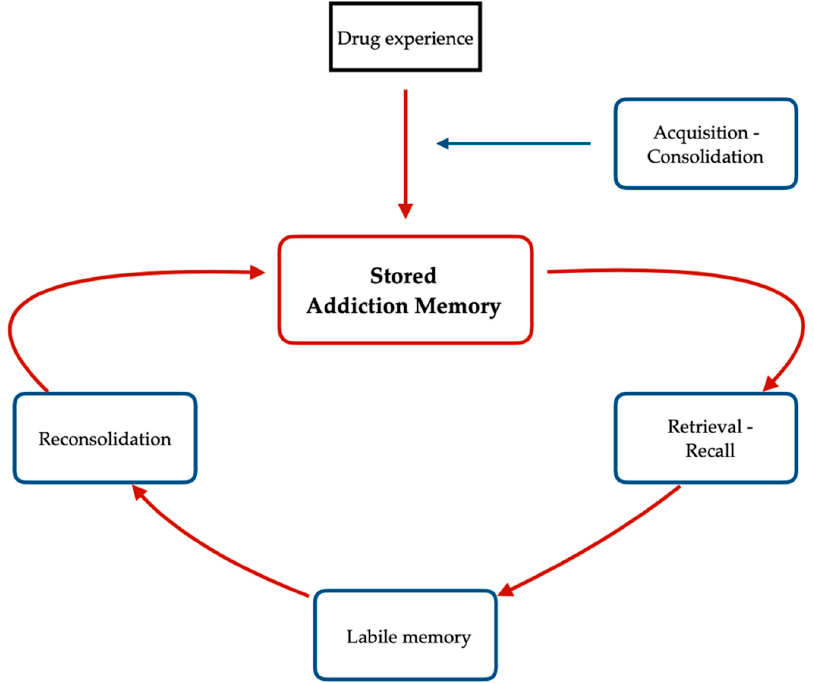
Figure 1. Schematic representation of the reconsolidation process of addiction memories. An experience is acquired (acquisition) and it becomes stronger over time (consolidation). When these memories are retrieved or recalled, they become labile, and this is related to specific intracellular protein degradation mechanisms—ubiquitin-proteasome system [128,130,131,133]. At this stage, memories are susceptible to being strengthened, weakened, or updated by pharmacological or non-pharmacological treatments for certain periods of time that are estimated from minutes to hours [13,133].